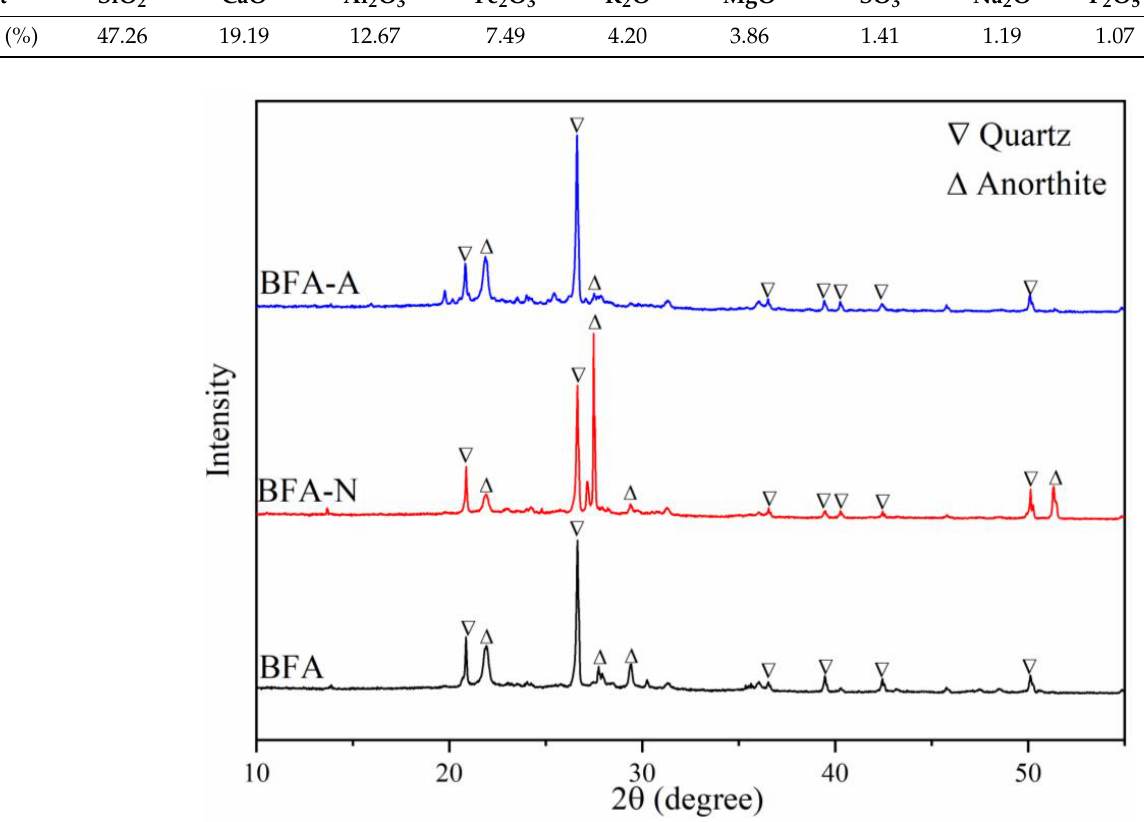
Figure 1. Mineral composition of BFA, BFA-N, and BFA-A.